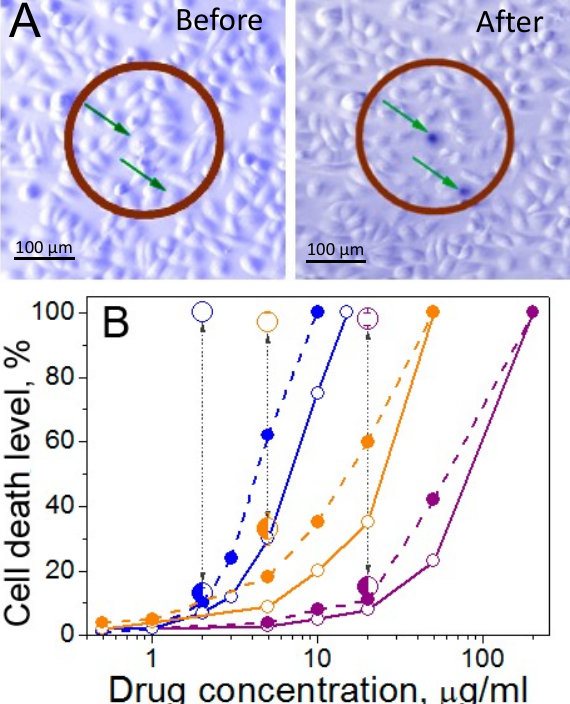
Figure 20. ( A ) Before : Bright-field optical microscopy images of a co-culture of normal (NOM9) and squamous cell carcinoma cells (HN31, green arrows) incubated with gold nanoparticles labeled with EFGR antibodies. After: A single laser pulse (70 psec, 820 nm, 40 mJ cm − 2 ) induced vapor nanobubbles in the HN31 cells without damaging the surrounding normal cells. The dead HN31 cells were stained with Trypan Blue (blue—dead cells, white—live cells). ( B ) Cell death level among cancer (solid lines) and normal (dotted lines) cells measured after 72 h of continuous free doxorubicin (blue), free cisplatin (orange), and liposome-encapsulated doxorubicin (Doxil, purple) exposure as a function of drug concentration. HN31 cells are drug-resistant; cancer cell death levels were lower than normal cells at all drug concentrations. NIR light-induced nanobubble formation induced by endocytosed antibody-labelled HGN increased the death level for cancer cells by 25 times for cisplatin, 6 times for doxorubicin, and 33 times for Doxil, while the death level remained low among normal cells (large circles). Near 100% cancer cell death was achieved at 10-fold reduced drug concentrations. Adapted from [119], published by Oxford, 1989.